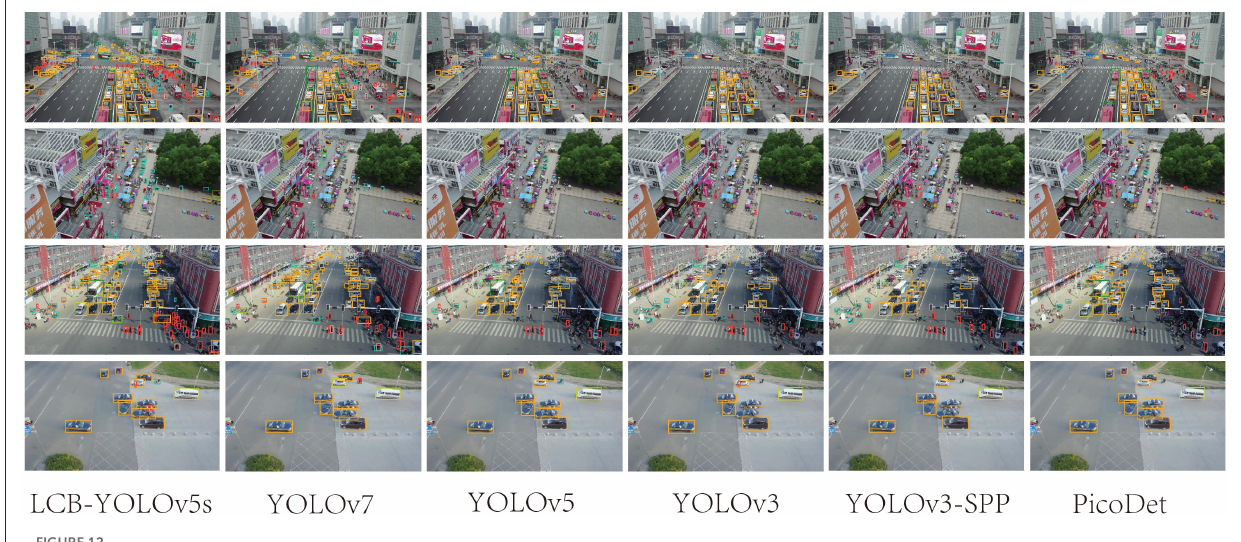
FIGURE12 Comparison of the target detection of six different models on the Visdrone2019